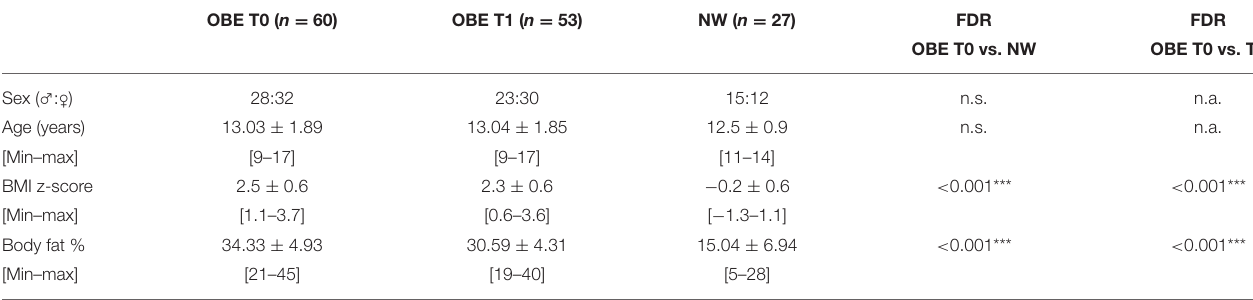
TABLE 2 | Sample characteristics.